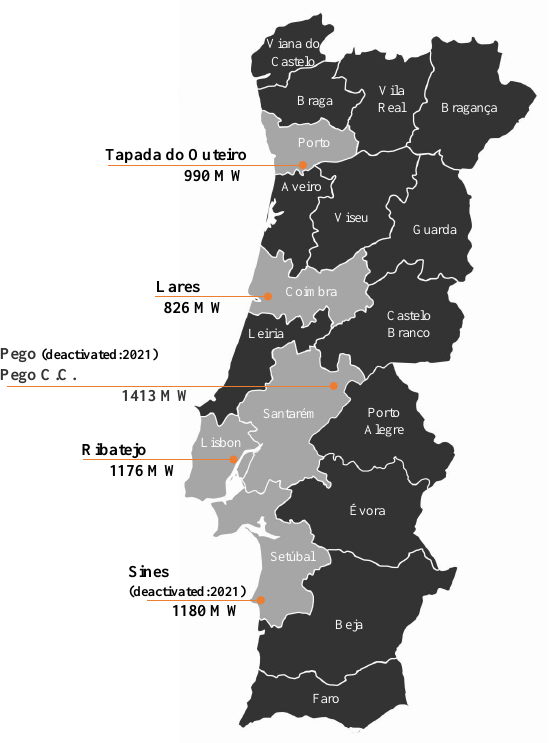
Figure 6. Portugal’s thermoeletric plants.